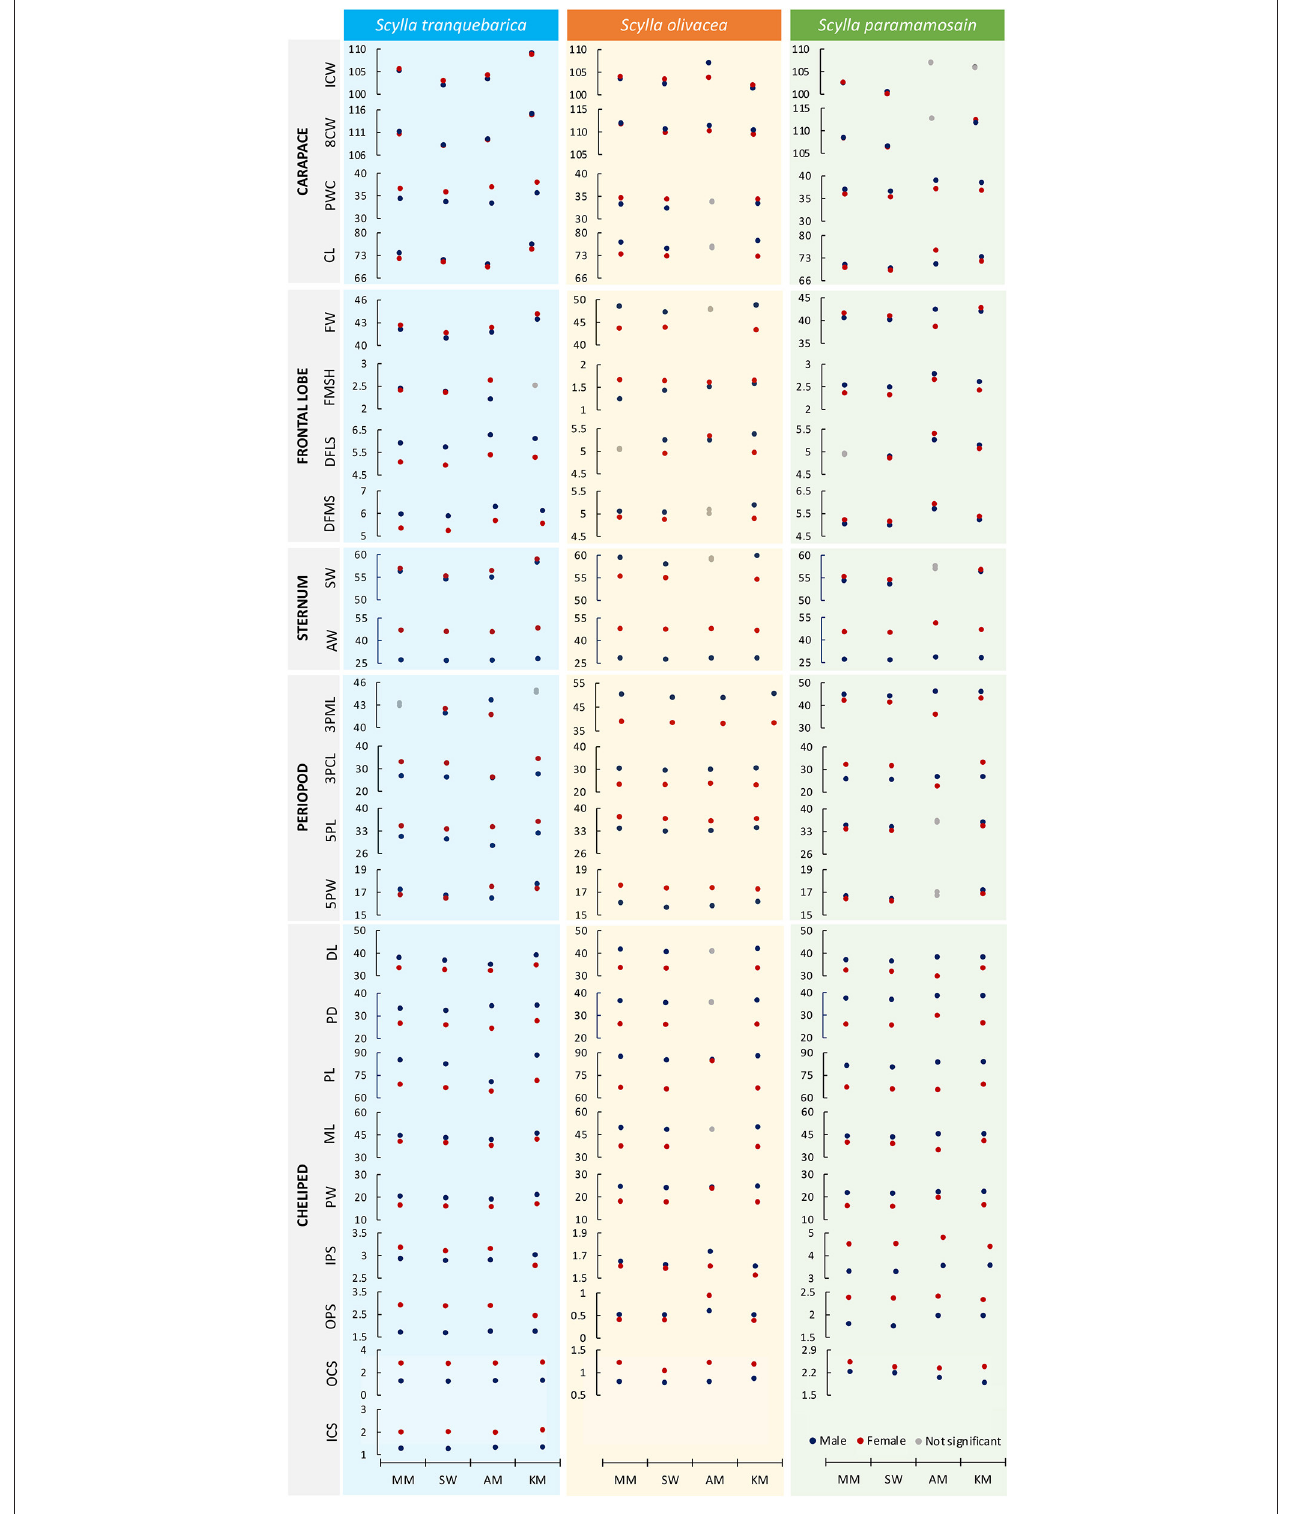
FIGURE 3 | Comparison of sexual dimorphism patterns across geographical locations for three Scylla species based on the estimated marginal means after controlling for the covariate (carapace width, CW) using ANCOVA. For detailed statistical values, refer to Supplementary Tables 6–8 . MM, Matang Mangrove Forest Reserve, Perak; SW, Setiu Wetlands, Terengganu; AM, Asajaya mangrove forest, Sarawak; KM, Kota Marudu mangrove forest, Sabah.